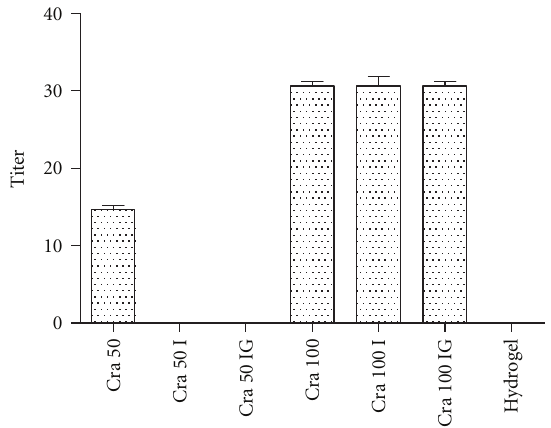
Figure 2: Evaluation of hemagglutinating activity of 1,4 Cramoll isolectin combined to the hydrogel excipient. Cra 50: Pure Cramoll 1,4 isolectin at 50 µ g/mL. Cra 50 I: Pure Cramoll 1,4 isolectin at 50 µ g/mL irradiated (15kGy h − 2 ). Cra IG: Pure Cramoll 1,4 isolectin at 50 µ g/mL associated with hydrogel excipient and irradiated (15kGy h − 2 ). Cra 100: Pure Cramoll 1,4 isolectin at 100 µ g/mL. Cra 100 I: Pure Cramoll 1,4 isolectin at 100 µ g/mL irradiated (15 kGy h − 2 ). Cra IG 100: Pure Cramoll 1,4 isolectin at 100 µ g/mL associated with hydrogel excipient and irradiated (15kGyh − 2 ). Hydrogel irradiated without lectin. The title was expressed as the highest dilution showing hemagglutinating activity. Values are mean ±